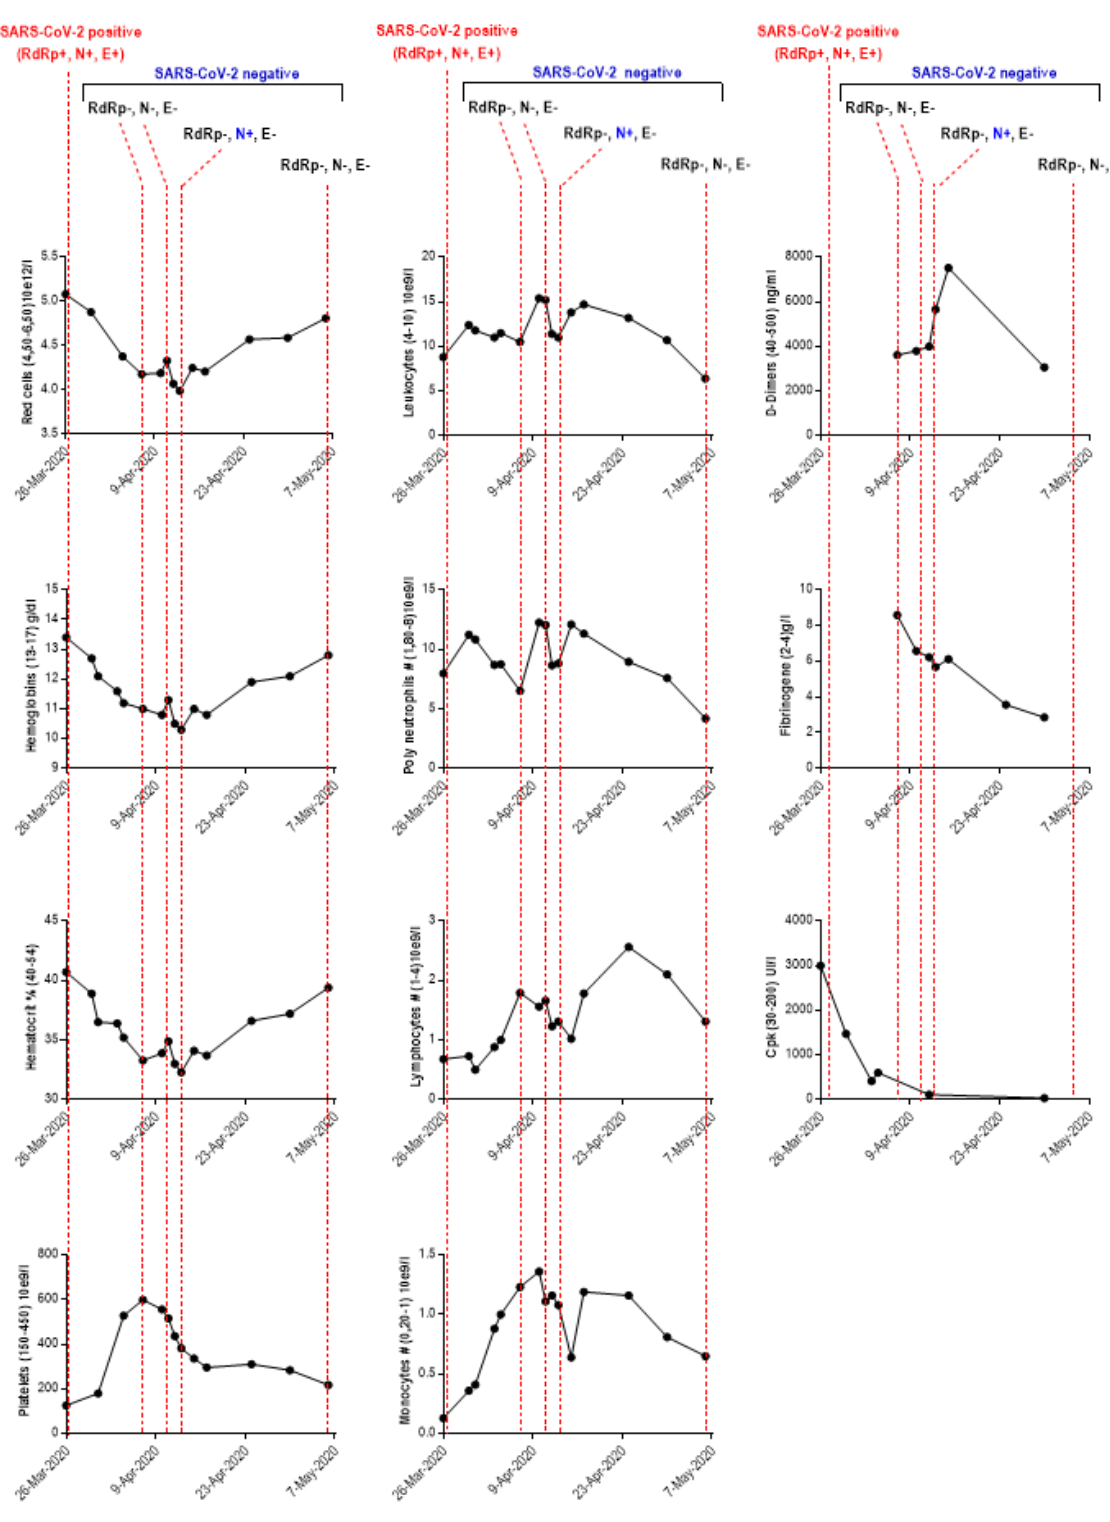
Figure 1. Dynamic profile of laboratory findings in patient with coinfection including SARS-CoV-2 and influenza H1N1. RdRp: RNA-dependent RNA polymerases; N: envelope protein N; S: Spike protein; CpK: creatine phosphokinase; SARS-CoV-2: severe acute respiratory syndrome coronavirus-2; Mar: March; Apr: April; #: Total count. The values between parentheses ‘()’ in the ordinate axis correspond to the reference range